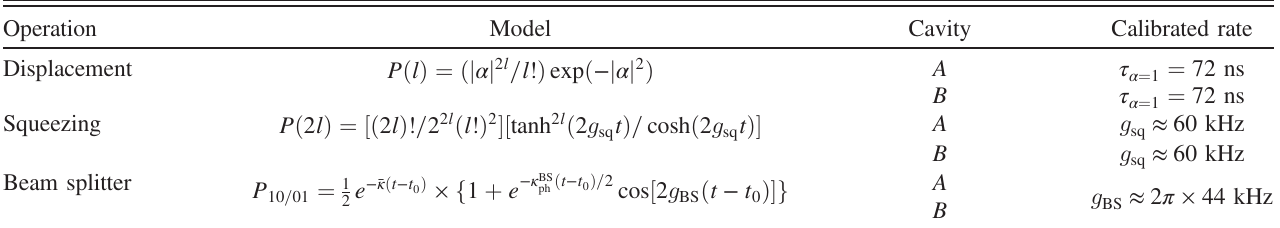
TABLE IV. Calibrated rates of Gaussian operations. The amplitude of a displacement operation of fixed length τ ¼ 72 ns is calibrated for generating a coherent state with α ¼ 1 [Fig. 4(a)]. The rates for the squeezing and beam splitter operations are extracted from the fits [Figs. 4(b) and